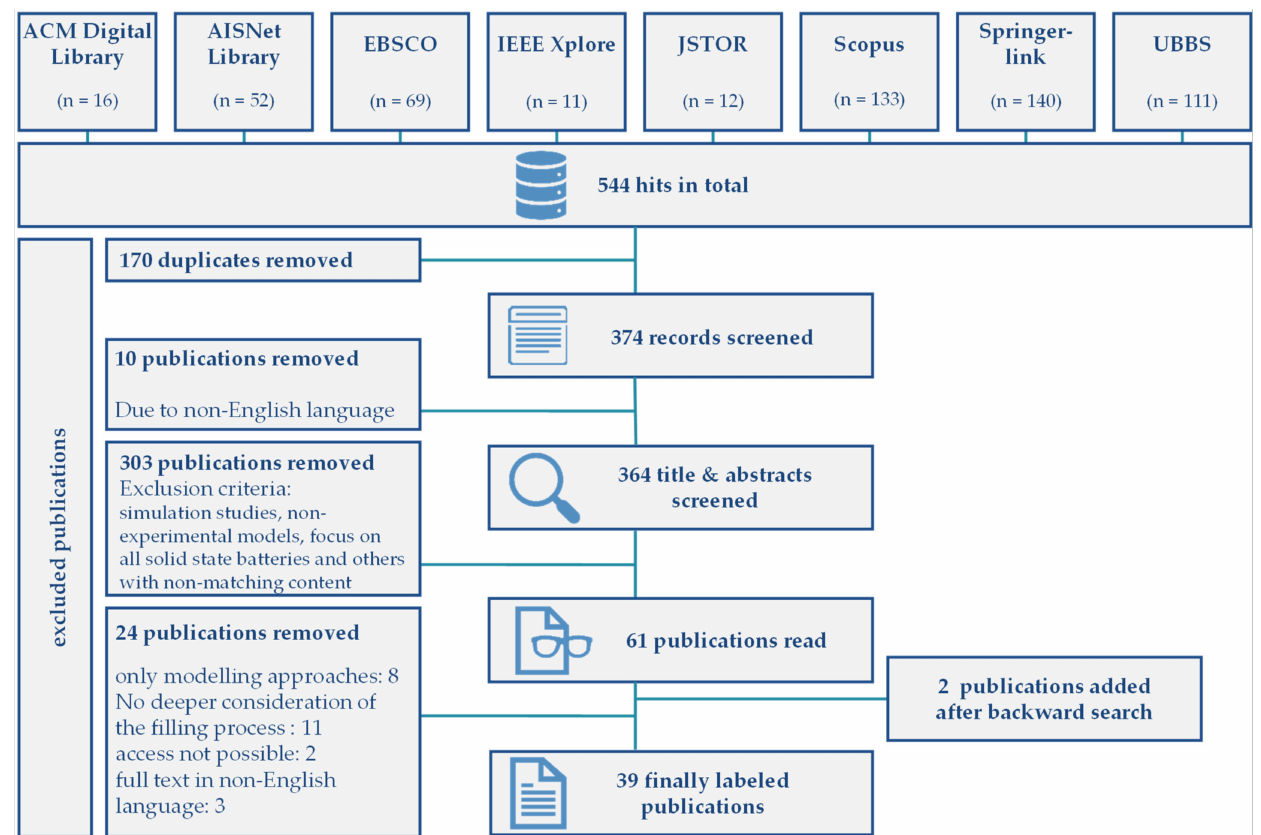
Figure 5. Paper selection process along the PRISMA